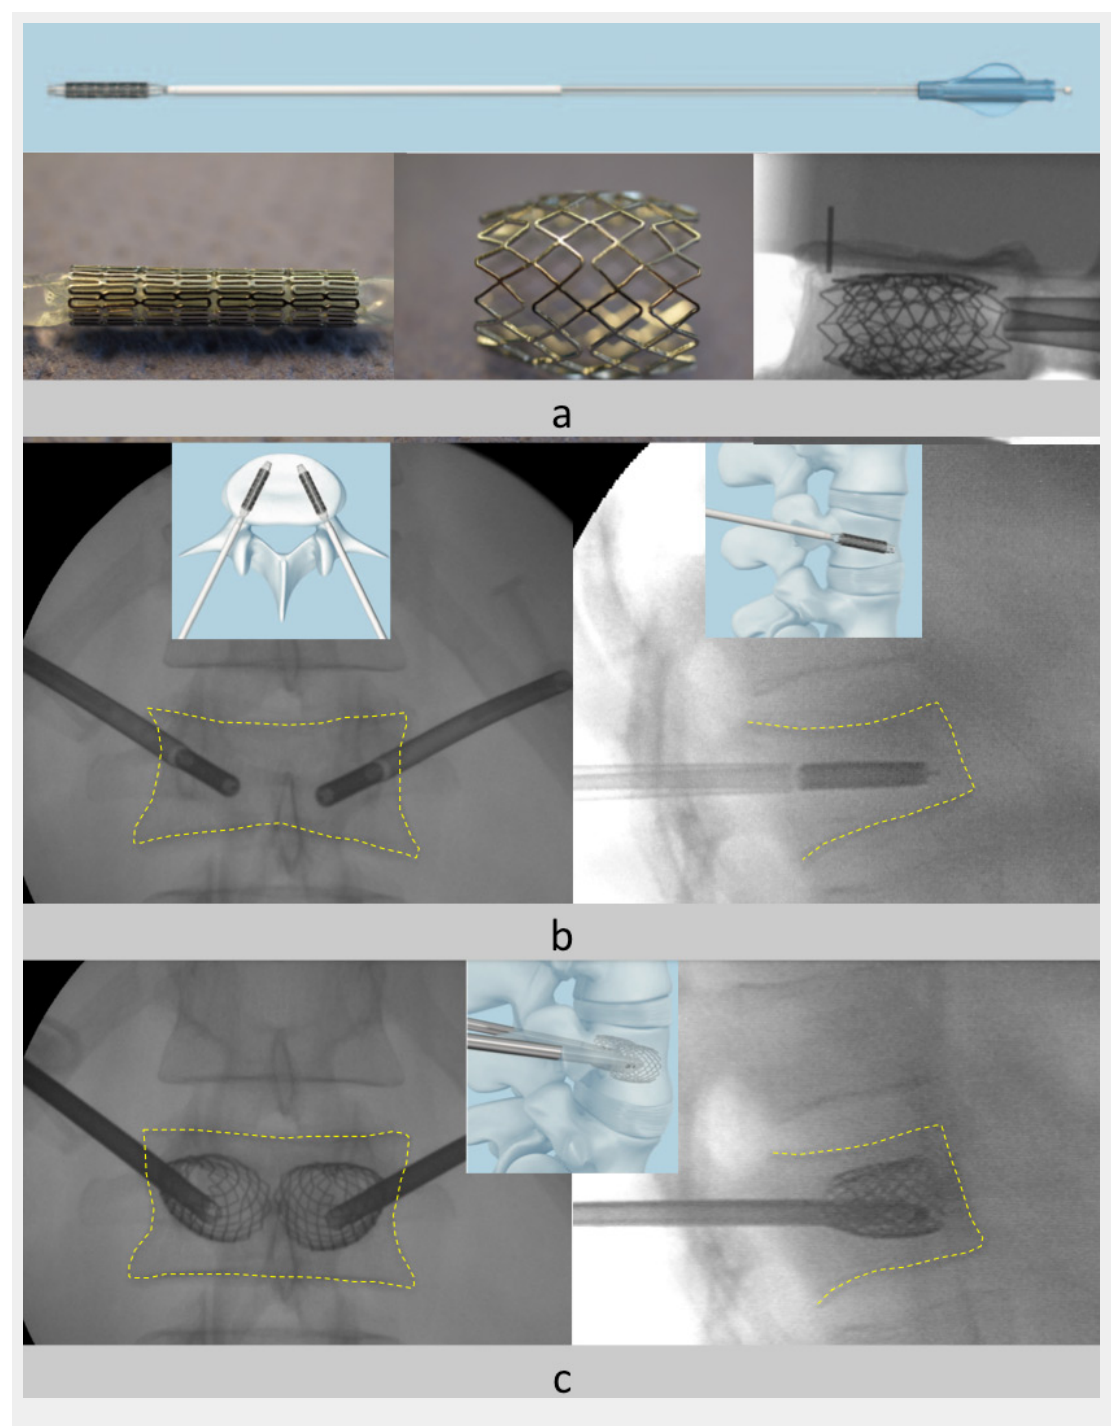
The vertebral body stent principle: A 4 mm stent with different lengths can be expanded up to 400%. It can provide preliminary stability and maintain the height gain before cement is injected; it cannot work as a standalone device (a). The stents are placed on each side through the pedicles (b). The stent is then expanded by the balloon. In this way the vertebral height (c) is restored. The final stabilisation is performed by the injection of bone cement (not shown here). The contours of the vertebral body are outlined by the yellow dashed